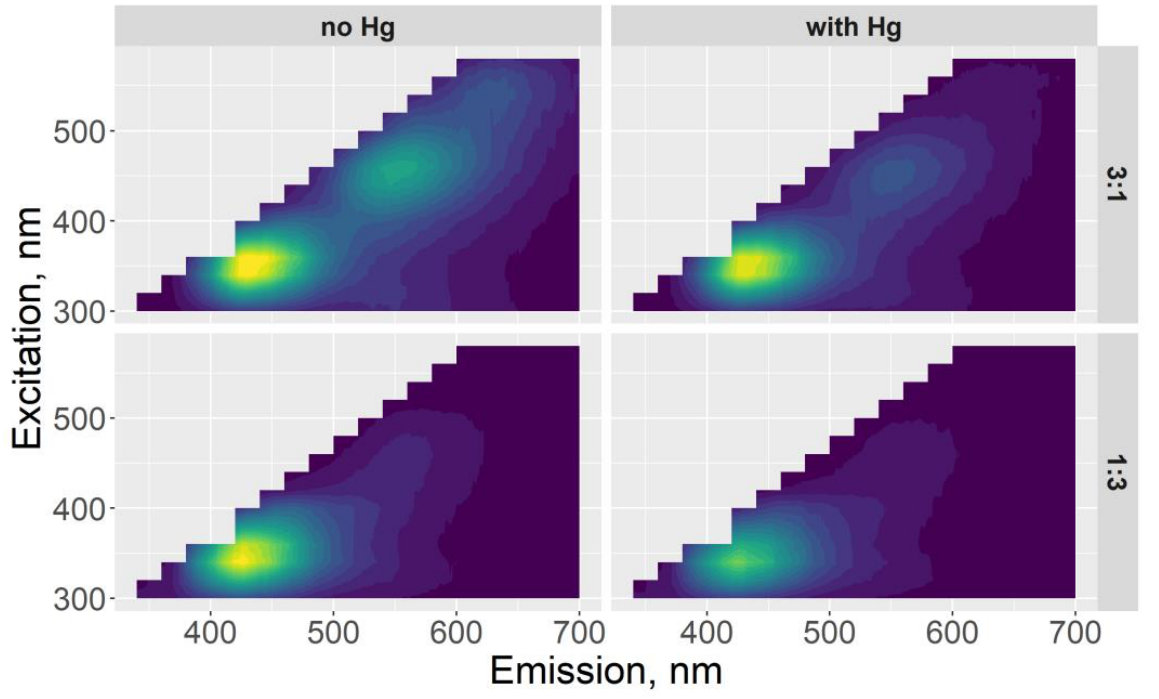
Figure 12. Effect of addition of 10 µmol/L of Hg(NO 3 ) 2 on the map of emission spectra of purified samples prepared from thiourea and citric acid. The presence of mercury(II) and the sample composition (thiourea: citric acid) are shown in the subplot captions.